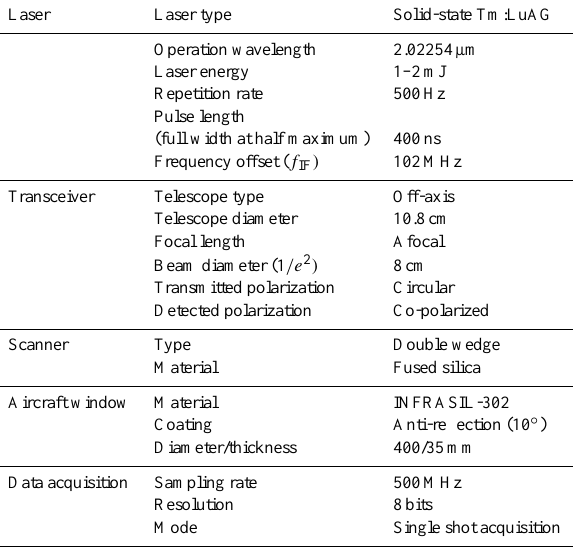
Table 1. Key parameters of the